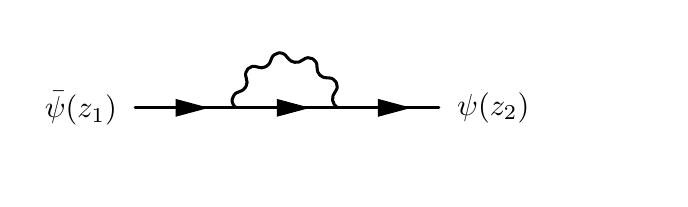
Figure 5: The single diagrams that contributes at order λ 2 to the fermion two-point function.